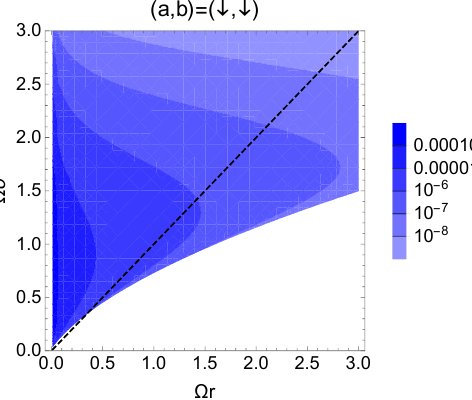
Figure 2. The contour plot of the negativity in the parameter space ( Ω r , Ω σ ) with the initial detectors’ state | ↓ A ↓ B (cid:105) . The dashed line represents the null curve r = σ